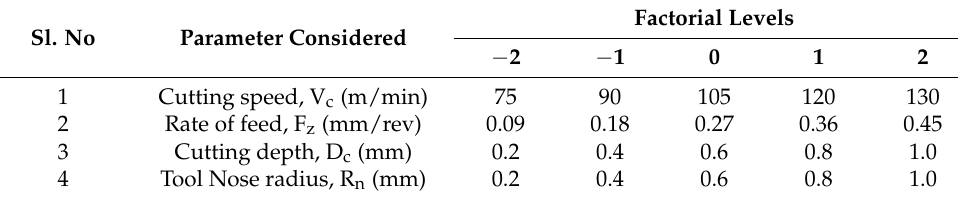
Table 1. The levels of process parameters.